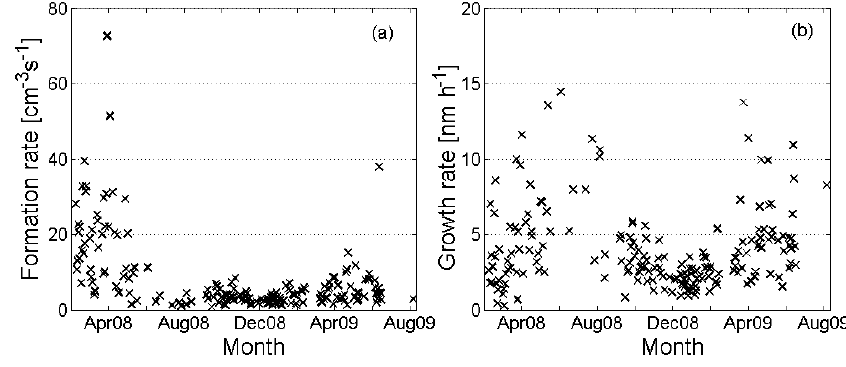
Page 10, right, line 14-15, During NPF events CS was usually low, varying from 0.001 to 0.12 s −1 with mean value of 0.02 s −1 . →During NPF events CS was usually low, with mean value of 0.02 s −1 . Fig. 8. The variation of formation rate (a) and growth rate (b) during measurement. 3